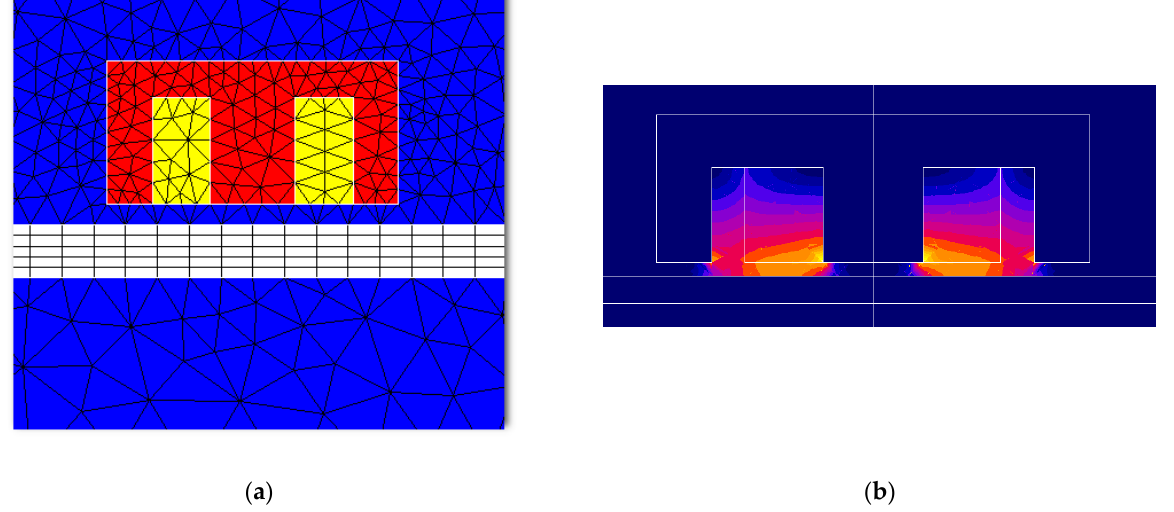
Figure 11. Division of the 2D system into finite elements ( a ); magnetic induction distribution in the inductor-cylinder system ( b ).